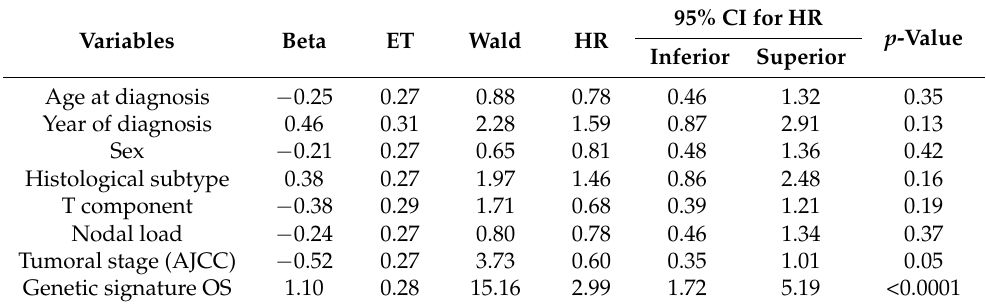
Table 2. Univariate Cox regression analysis. The impact of independent categorical variables on OS was